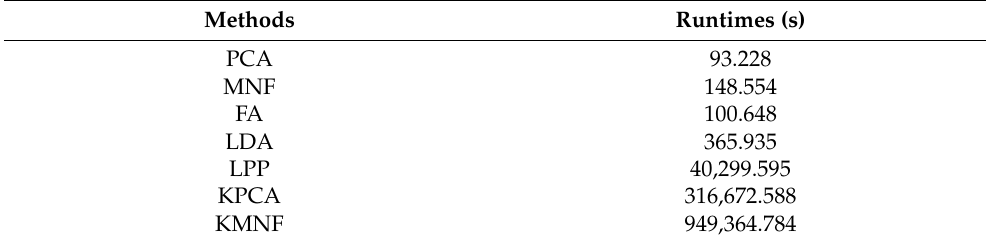
Table 6. The runtimes of each feature extraction method with a data size of 100 × 100 × 250. Methods Runtimes